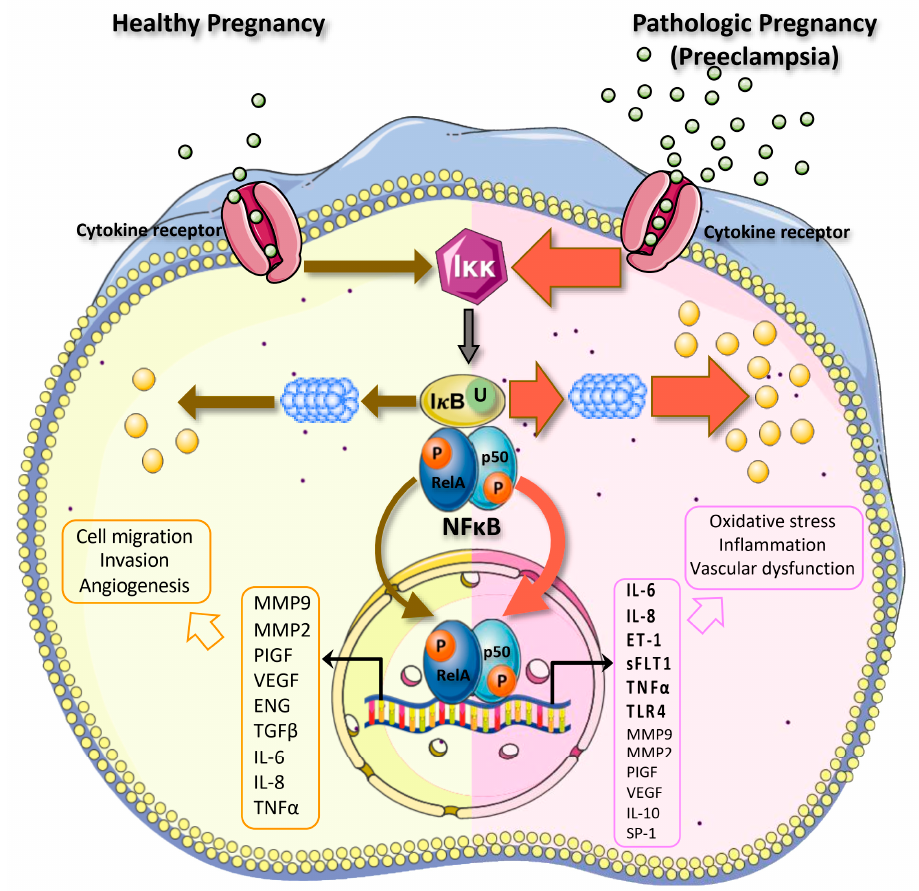
Figure 1. Actions of NF κ B in the healthy and preeclamptic placenta. During normal pregnancies, NF κ B functions to support the cellular migration, invasion, and production of angiogenic proteins from the placenta, through activation of several target genes. During pathological pregnancies such as preeclampsia (PE), NF κ B is highly expressed as described by the red arrows. NF κ B may induce expression of pro-inflammatory and anti-angiogenic proteins, further promoting oxidative stress, inflammation, and vascular dysfunction that occurs in PE.